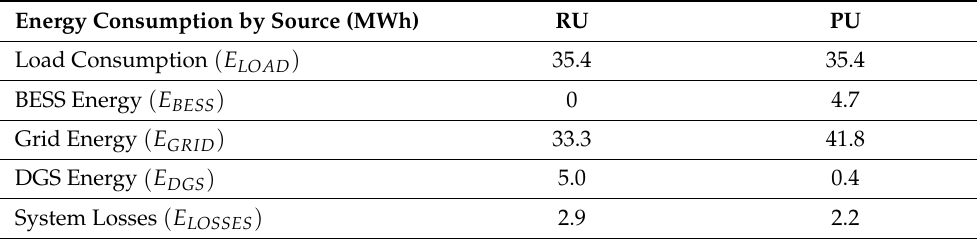
Table 4. Energy consumed by each energy resource for the reference unit (left column) and the pilot unit (right column) based on SCADA measurements (MWh/month).